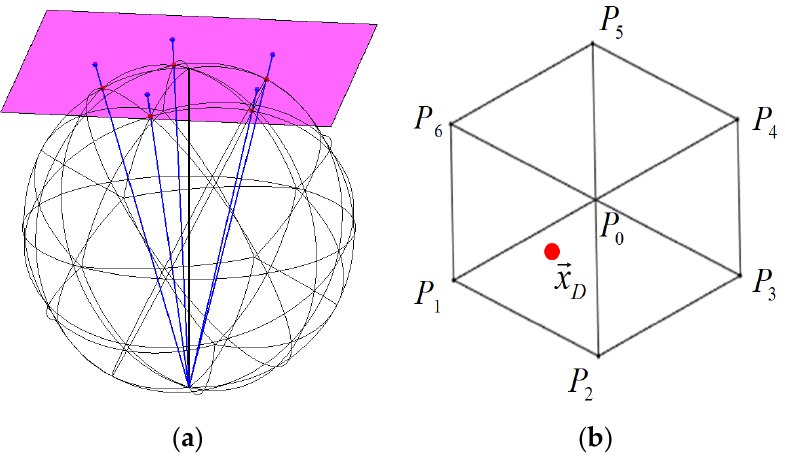
Figure 4. General stereography projection on a local stencil on the icosahedron sphere ( a ) icosahedron spherical triangle mesh with refinement level 1, the stereographic projection of north pole, and its nearest five neighbor points are shown in red dot, the mapped points are shown in blue dot on the local 2D tangent plane shown in pink; ( b ) the first-order neighbor points for a specific vertex. The number of first-order neighbor points around each vertex is 6 (except for the 12 original major points, the number of first-order neighbor points around is 5).